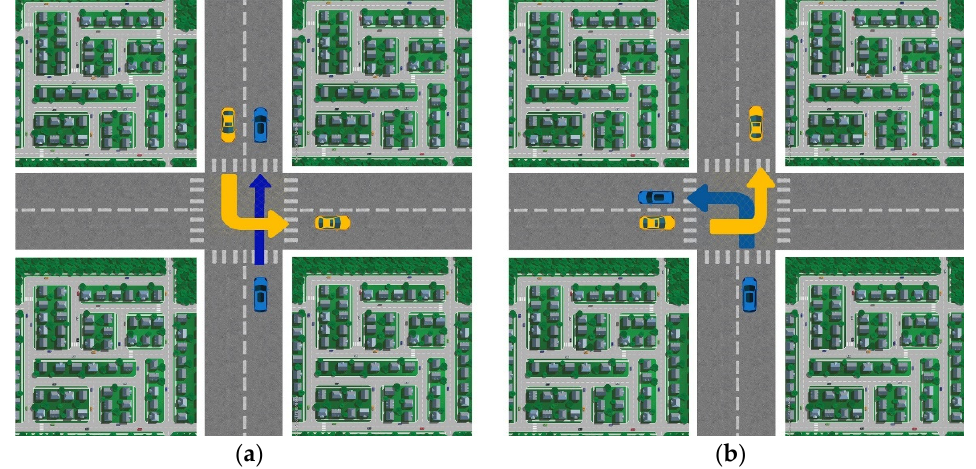
Figure 3. Examples of crossing conflict: ( a ) shows crossing conflict occurs when vehicles have different movements; ( b ) shows crossing conflict occurs when vehicles have similar movements.